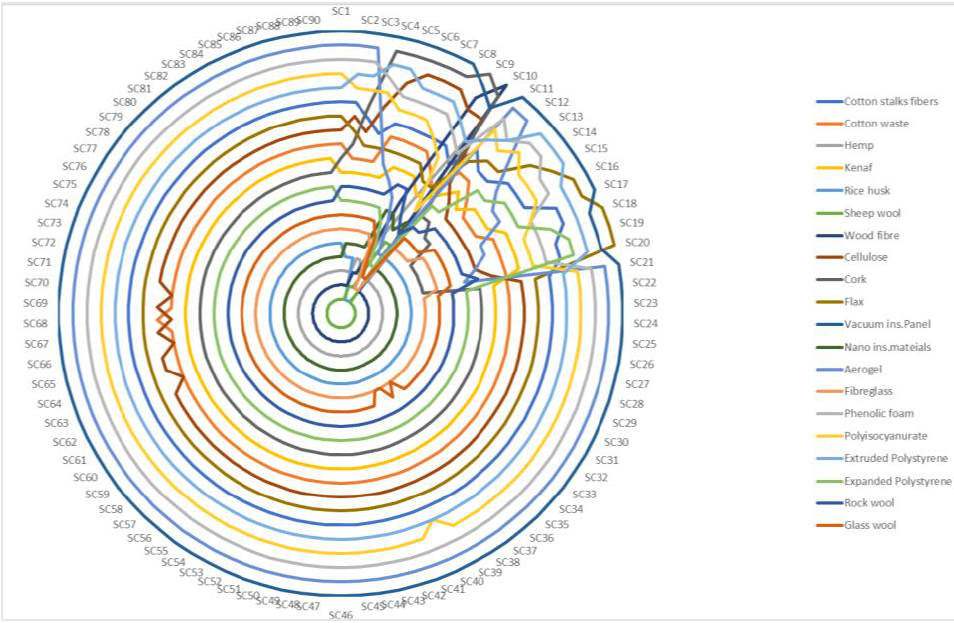
Figure 1. The ranking of alternatives by taking different criteria weights into